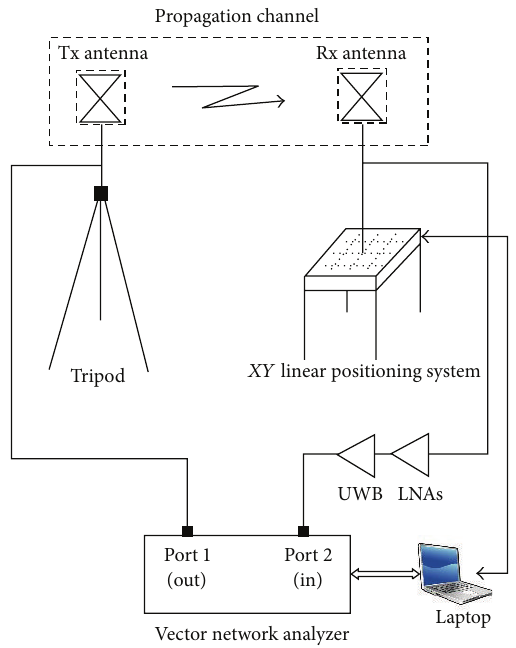
Figure 2: Overview of the frequency-domain propagation channel measurement setup.